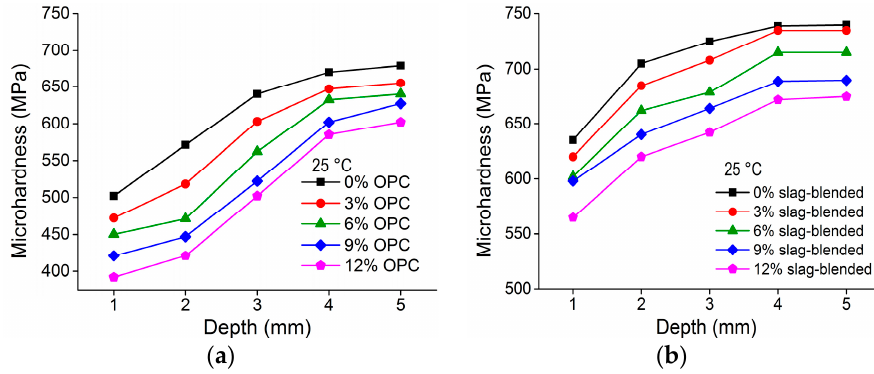
( b ) Figure 7. Mass variation in nano-TiO 2 containing OPC mortars immersed in 10% Na 2 SO 4 solution at ( a ) 25 °; ( b ) 5 °C. ( a ) ( b ) Figure 8. Mass variation in nano-TiO 2 containing slag-blended mortars immersed in 10% Na 2 SO 4 solution at ( a ) 25 °C; ( b ) 5 °C. 3.3. Microhardness The variation in Vickers hardness in OPC and slag-blended mortars immersed in 10% Na 2 SO 4 solution at 25 °C is shown in Figure 9. It shows a greater loss of surface hardness with the addition of nano-TiO 2 . This figure also shows that sulfate attack caused a greater loss of surface hardness in